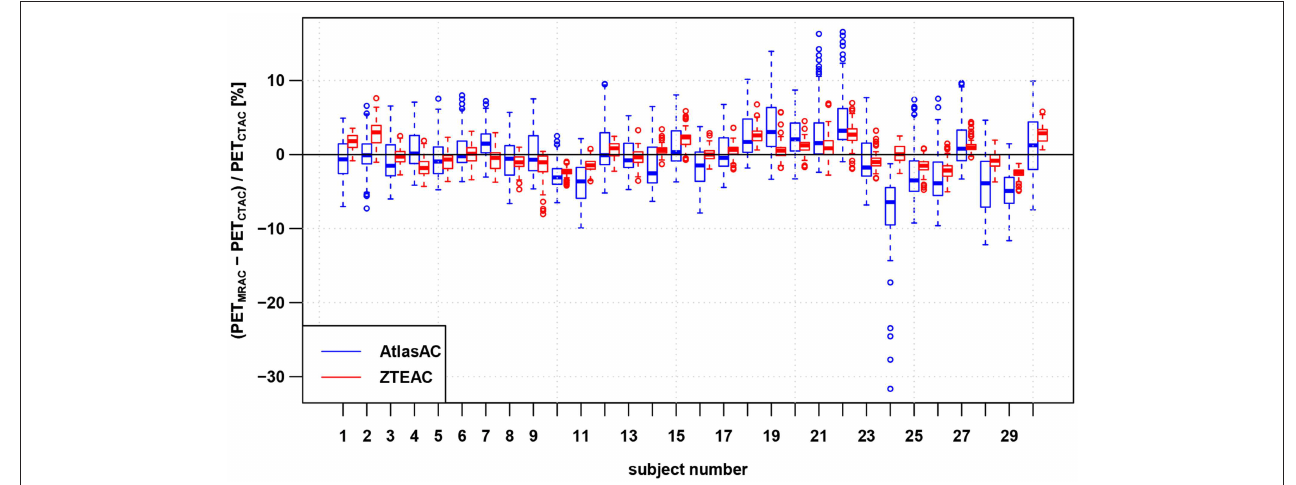
FIGURE 2 | Regional bias in the PET reconstruction caused by AtlasAC (blue) and ZTEAC (red) compared to CTAC for all 30 static PET acquisitions. Each box plot shows the bias distribution over the 85 anatomical VOIs. The rectangular boxes represent the interquartile ranges (IQR) and the horizontal line are the medians. The upper ends of the whiskers are at the minimum of the third quartile plus 1.5IQR and the biggest data point The lower ends of the whiskers are at the maximum of the first quartile minus 1.5IQR and the smallest data point. Outliers are plotted as open circles. Please note that the VOIs in the cerebellum had to be excluded in three subjects (6, 7, 21).